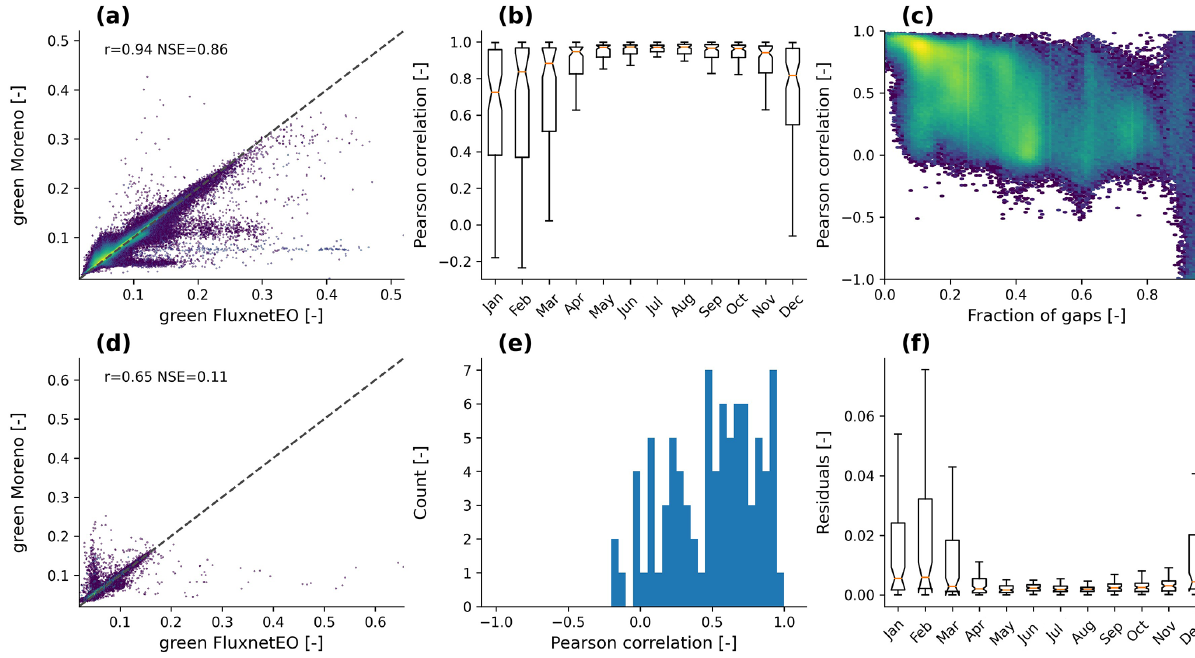
Figure C4. Same as Fig. C3 but for the green spectral band.